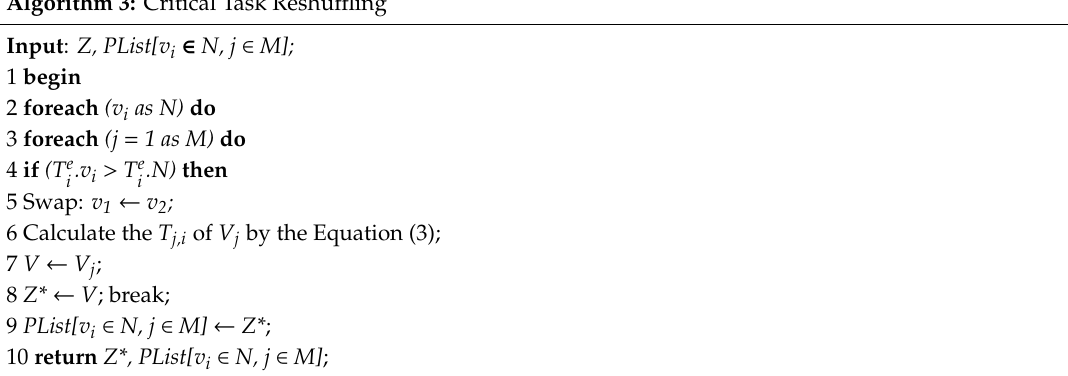
Algorithm 3: Critical Task Reshu ffl ing